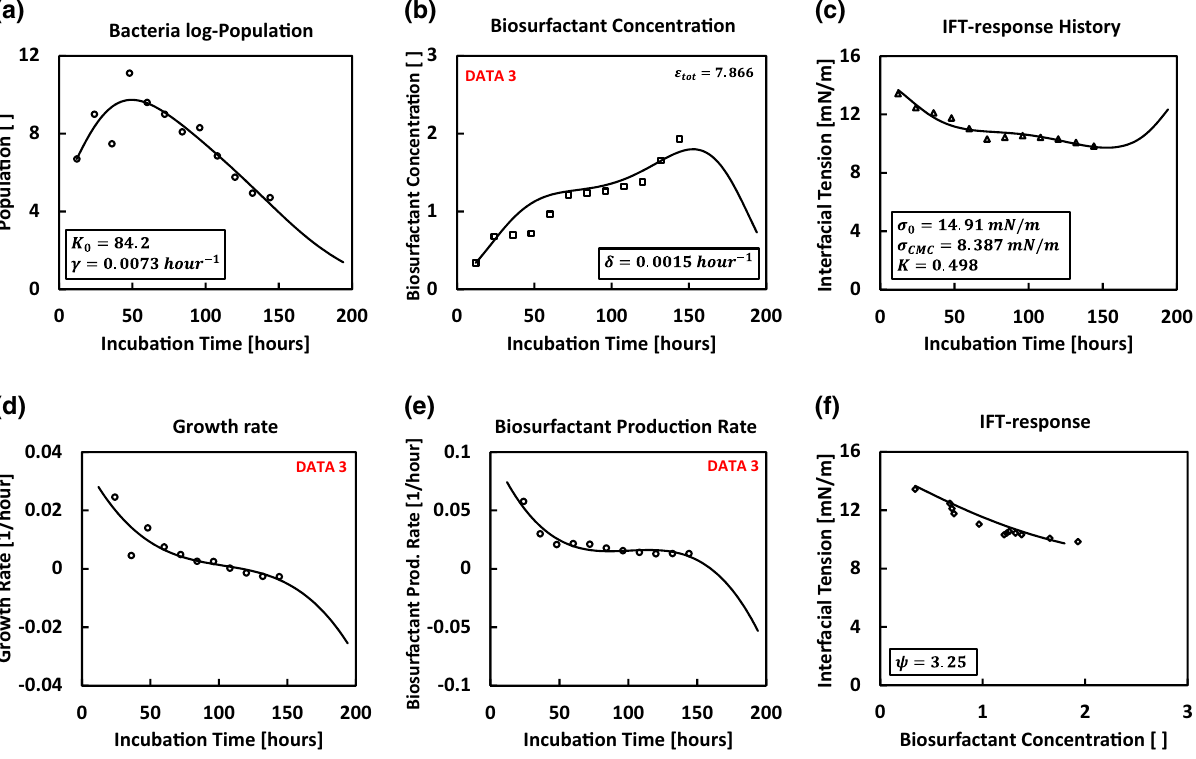
Fig. 8 Coupled-simultaneous model (CSM). The computation uses Eq. (14) and DATA